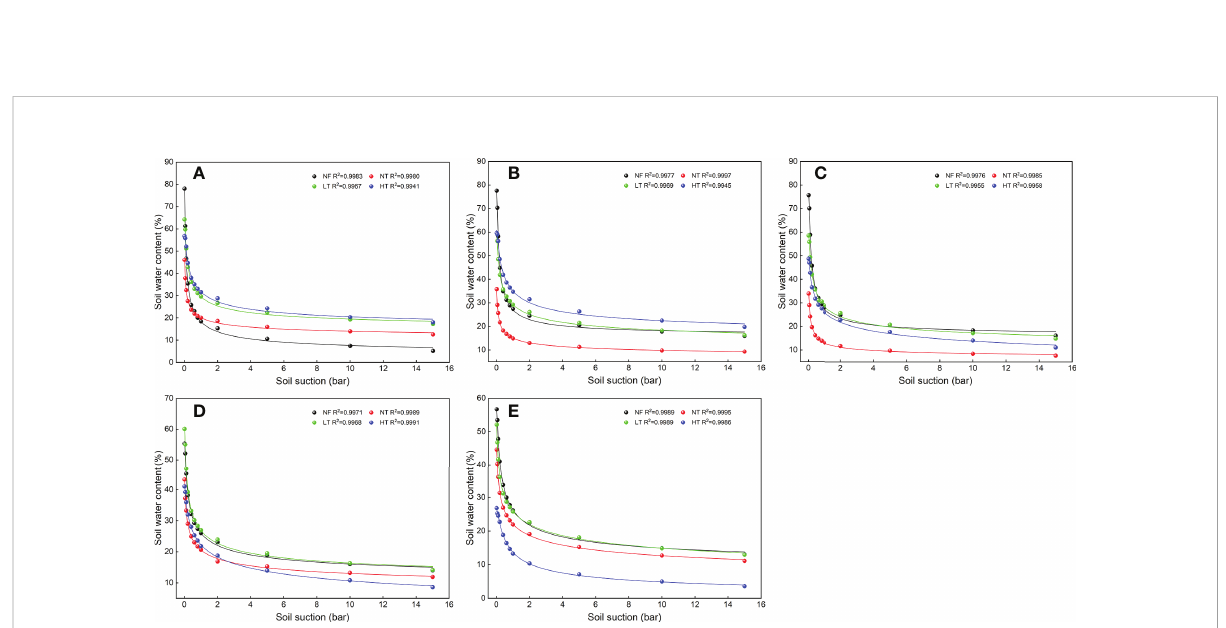
FIGURE 3 Soil water characteristic curves fi tting with the Van Genuchten model for different soil depths under different management practices of P. crassifolia . Labels (A – E) indicate different soil depths, namely 0-10cm, 10-20cm, 20-40cm, 40-60cm, and